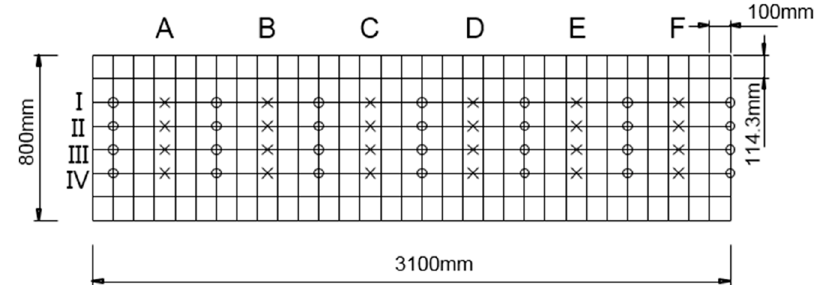
Figure 10. A planar view of the 114 × 100 mm 2 test point grid for P-wave measurements. The test was carried out on the grid locations. The O and X marks indicate the positions of the transducers and average measurements, respectively. All dimensions in millimeters.